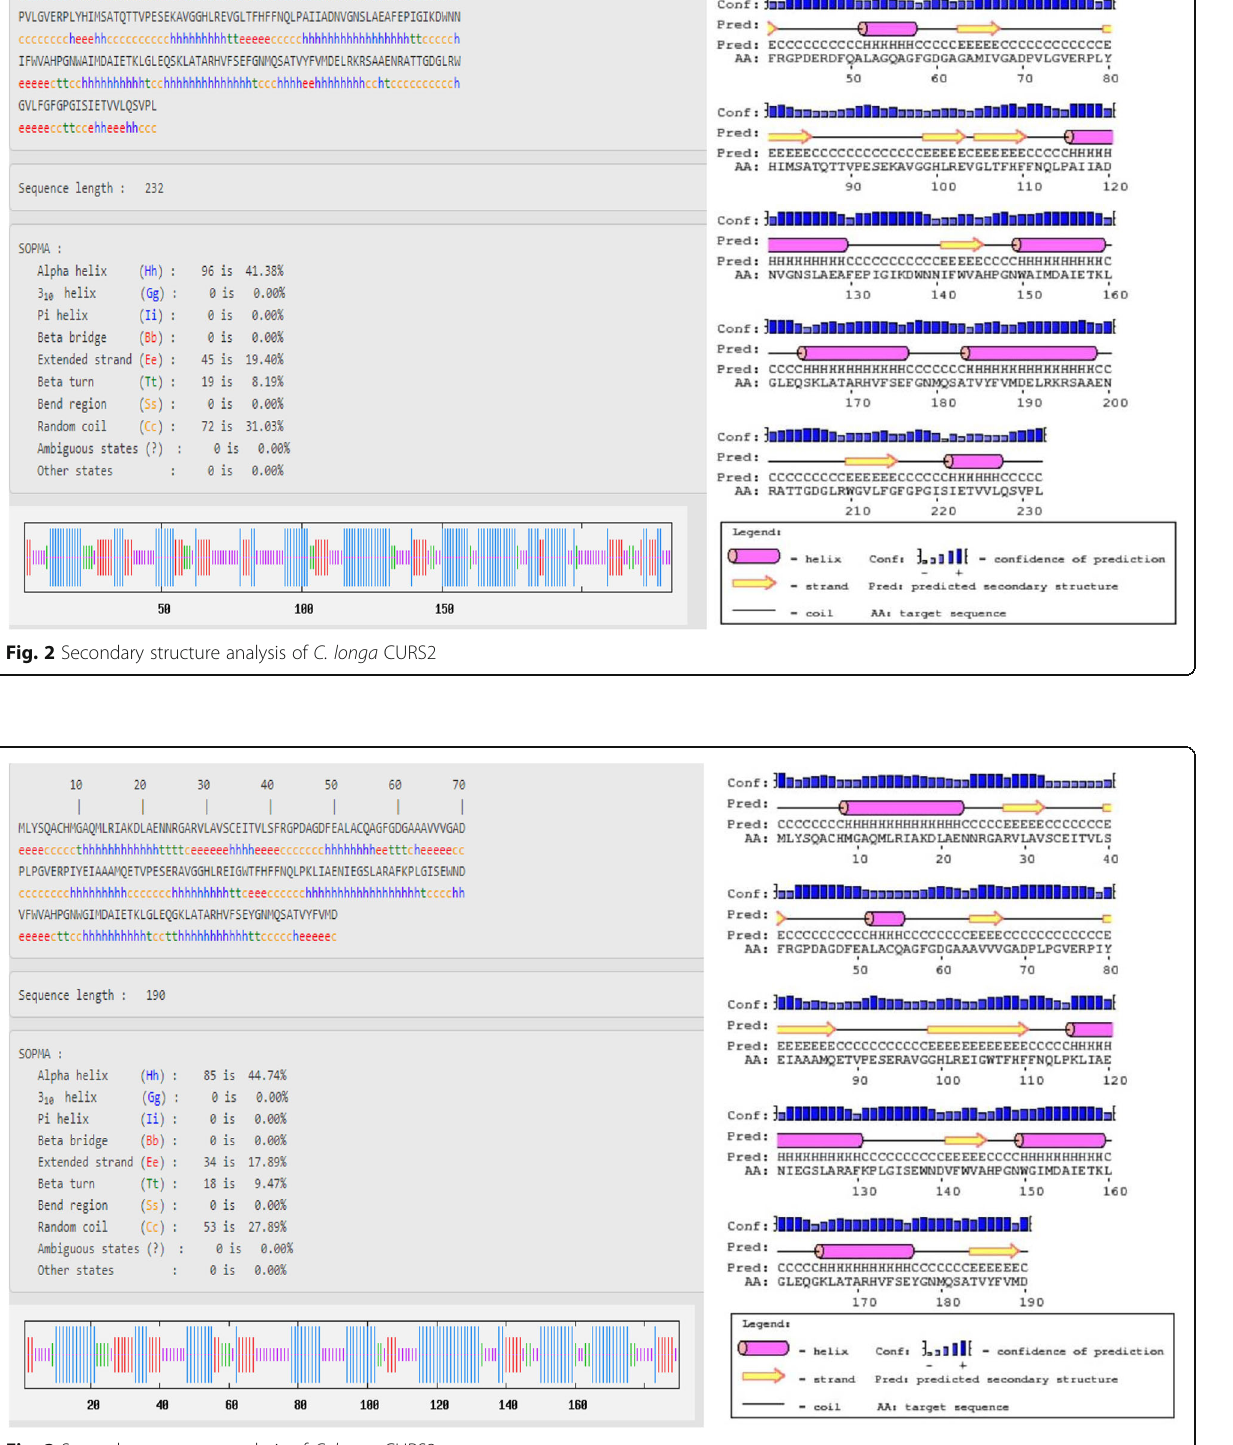
Fig. 3 Secondary structure analysis of C. longa